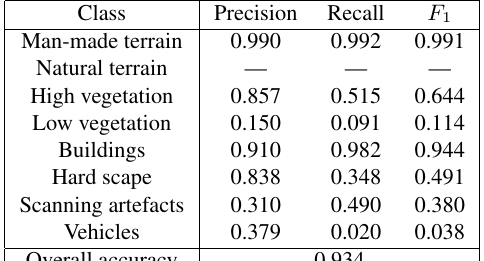
Table 2. Evaluation of using TUM dataset.